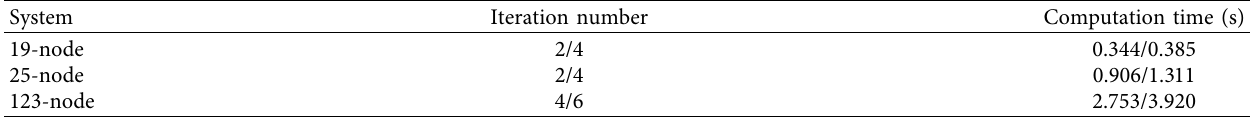
Table 13: Comparison of computational performances